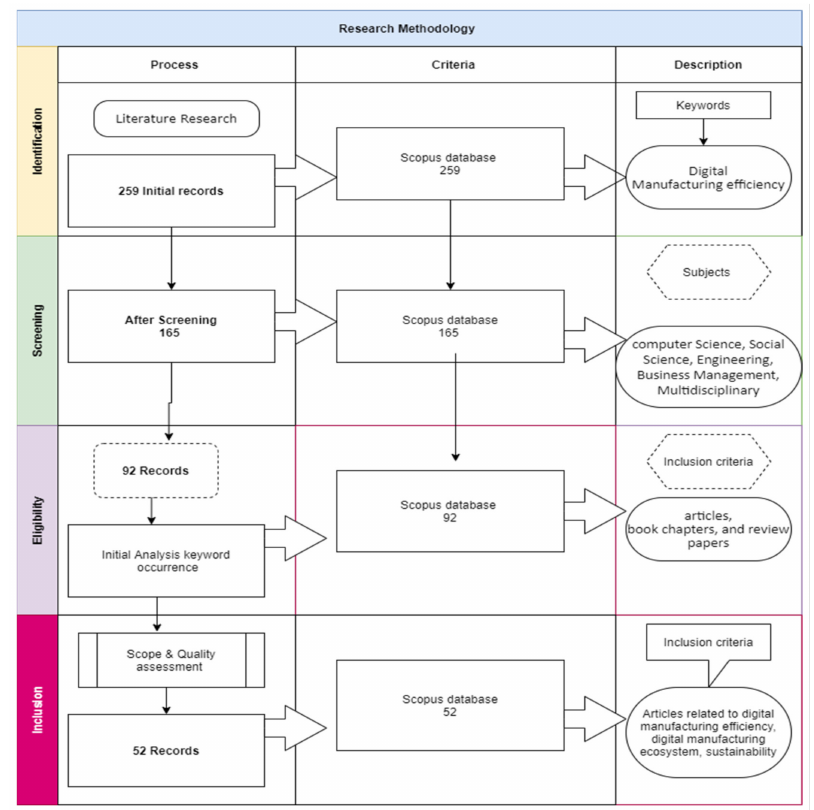
Figure 1. PRISMA statement